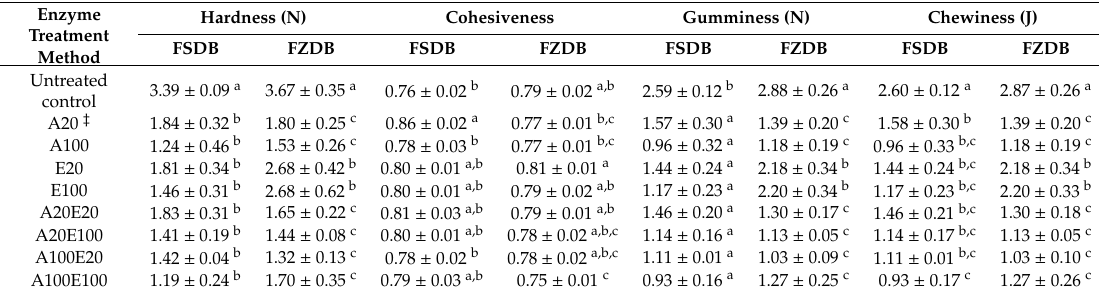
Table 1. Texture profile analysis results of enzyme-treated fresh and frozen bread doughs at storage of day 0 †